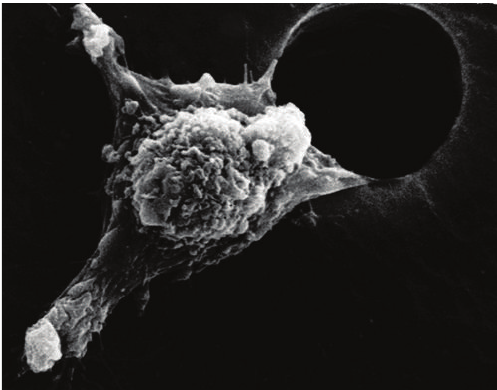
Figure 11: SEM of a cancer cell movement through a man-made hole involves “arms” or pseudopodia, termed lamellipodia, enabling them to migrate to other parts of the body. Locomotion cell motility is integral to the entire process of invasive metastasis. (With permission from the National Institutes of Health/Department of Health and Human